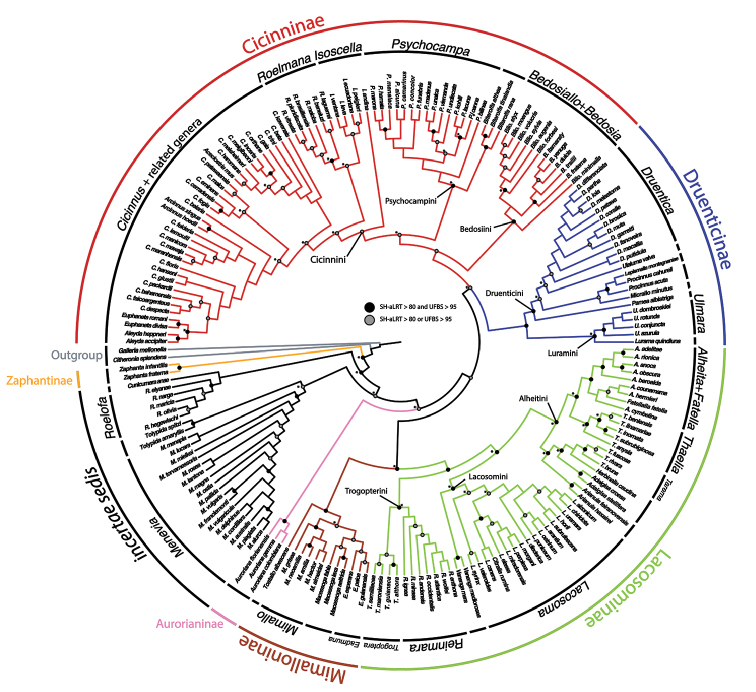
Maximum likelihood tree built using IQ-TREE with a backbone constraint (Suppl. material 4) from the phylogenomic study of St Laurent et al. (2018a). Branch lengths are removed so that relationships can be easily visualized. Asterisks denote nodes that were topologically constrained. For branch lengths and all support values, see Suppl. material 6.